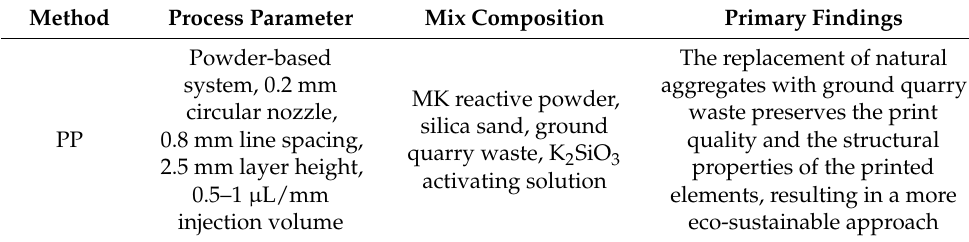
Table 7. Details of [90] research work.